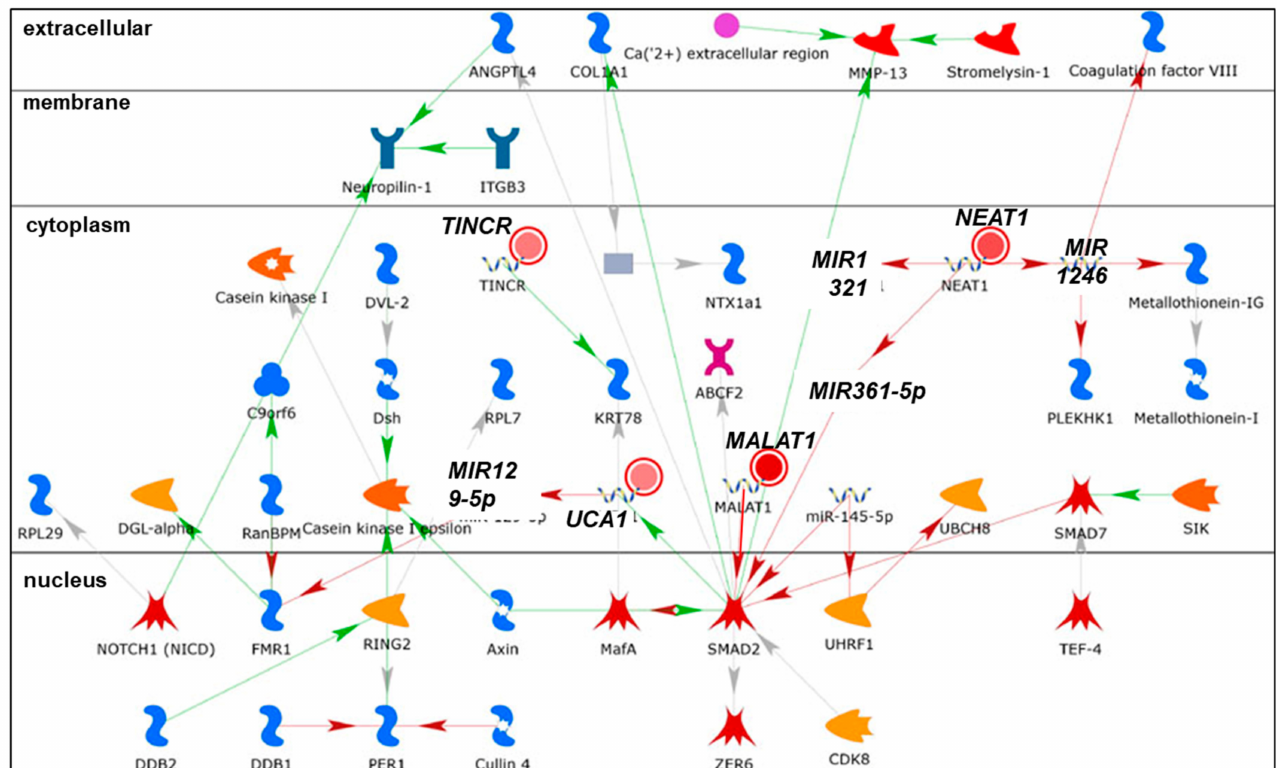
Figure 6. Network 1: NEAT1, UCA1, MALAT1, TINCR, and SMAD2, identified in lncRNAs upregulated by miR-29b-1-3p and miR-29a-3p in MCF-7 and/or LCC9 cells by MetaCore analysis; green lines with arrows = stimulation; red lines with arrows = inhibition.